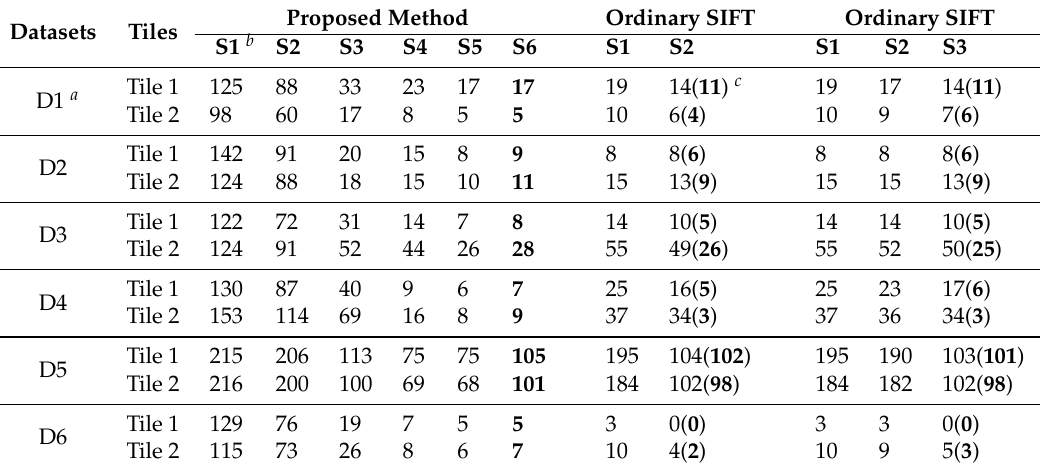
Table 2. The number of remaining matches after each step in the three